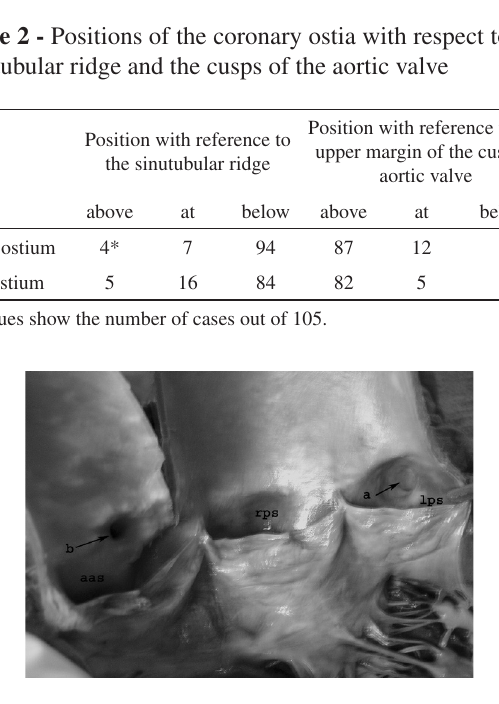
Figure 3 - The left coronary ostium (arrow a) in the left posterior sinus (lps). The sinutubular ridge is arched to accommodate the ostium within the sinus. The right coronary ostium is present at the ridge (arrow b)